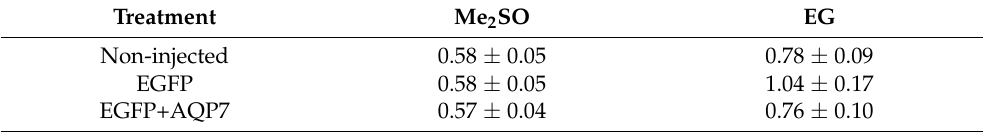
Table 5. Permeability to cryoprotectants ( P s ) of bovine oocytes injected with EGFP alone or EGFP+AQP7 cRNA measured in HM medium containing 9.5% Me 2 SO or 8% EG at 25 ◦ C.